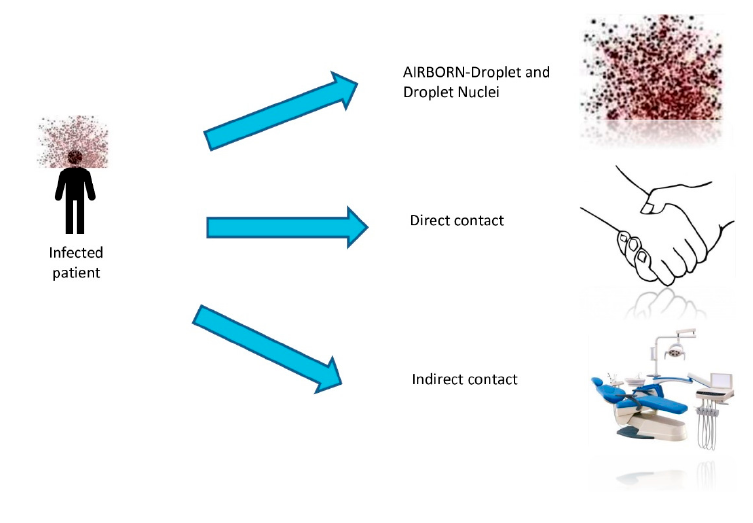
Figure 4. The transmission routes of COVID-19 (figure drawn by Giovanna Dipalma)